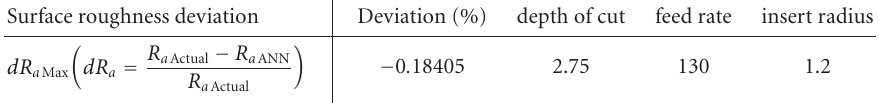
Table 14: Maximum deviation for surface roughness values.